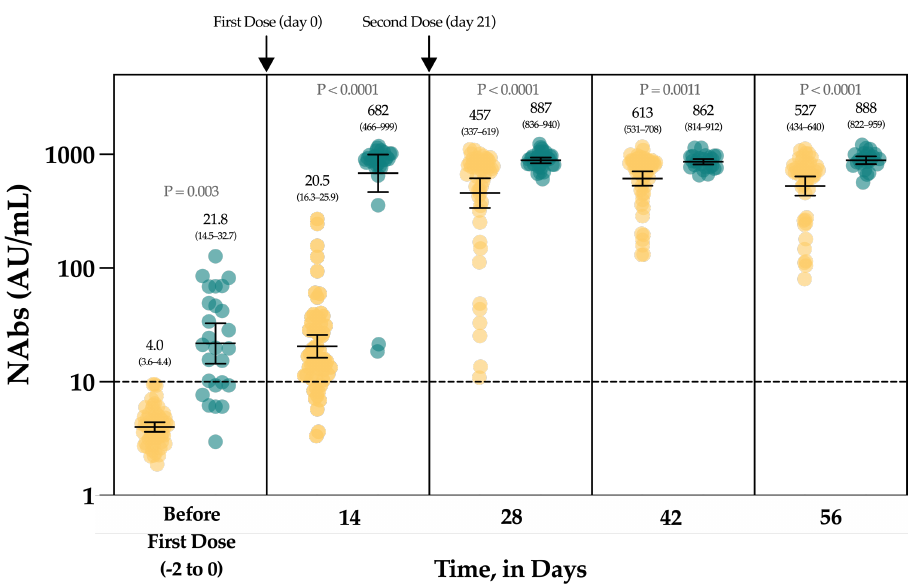
Figure 4. The evolution of NAbs in a group of 90 vaccinated participants. Uninfected individuals are represented in yellow and previously infected individuals are represented in green turquoise. The black dotted line corresponds to the positivity threshold of 10 AU/mL.